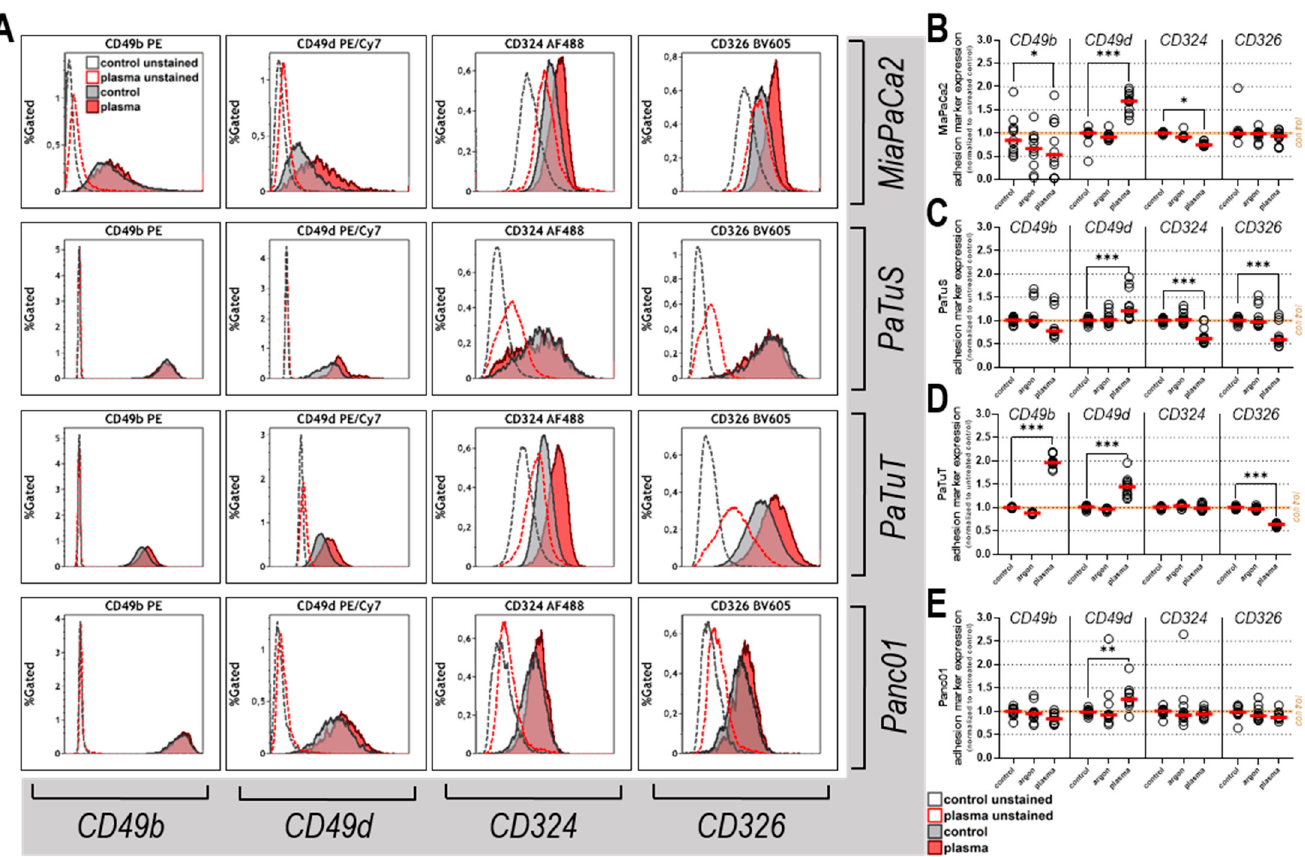
Figure 3. Plasma treatment modulated the expression of cell adhesion markers. ( A ) representative overlays of fluorescence intensity fluorochrome-labeled antibodies targeting CD49b, CD49d, CD324, and CD326 on human pancreatic cancer cells: unstained control cells (grey dashed line), unstained plasma-treated cells (red dashed line), stained control cells (gray histogram), and stained plasma-treated cells (red histogram) 24 h after treatment; fold change of adhesion marker expression normalized to untreated control and corrected for autofluorescence values for ( B ) MiaPaCa2, ( C ) PaTuS, ( D ) PaTuT, and ( E ) Panc01 cells. Data are mean (red line) and single values (circles) of four independent experiments.